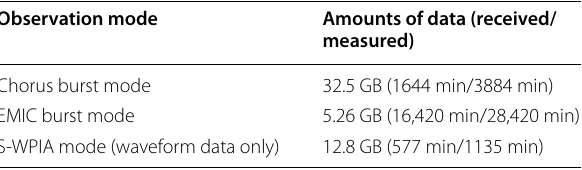
Table 6 Total amount of waveform data obtained by